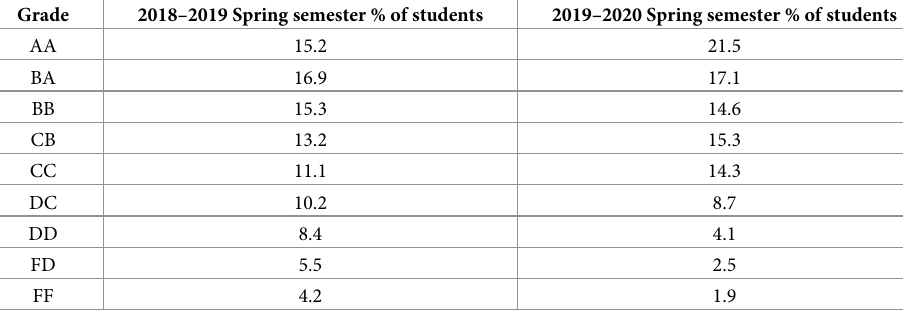
Table 2. Distribution of letter grades given to